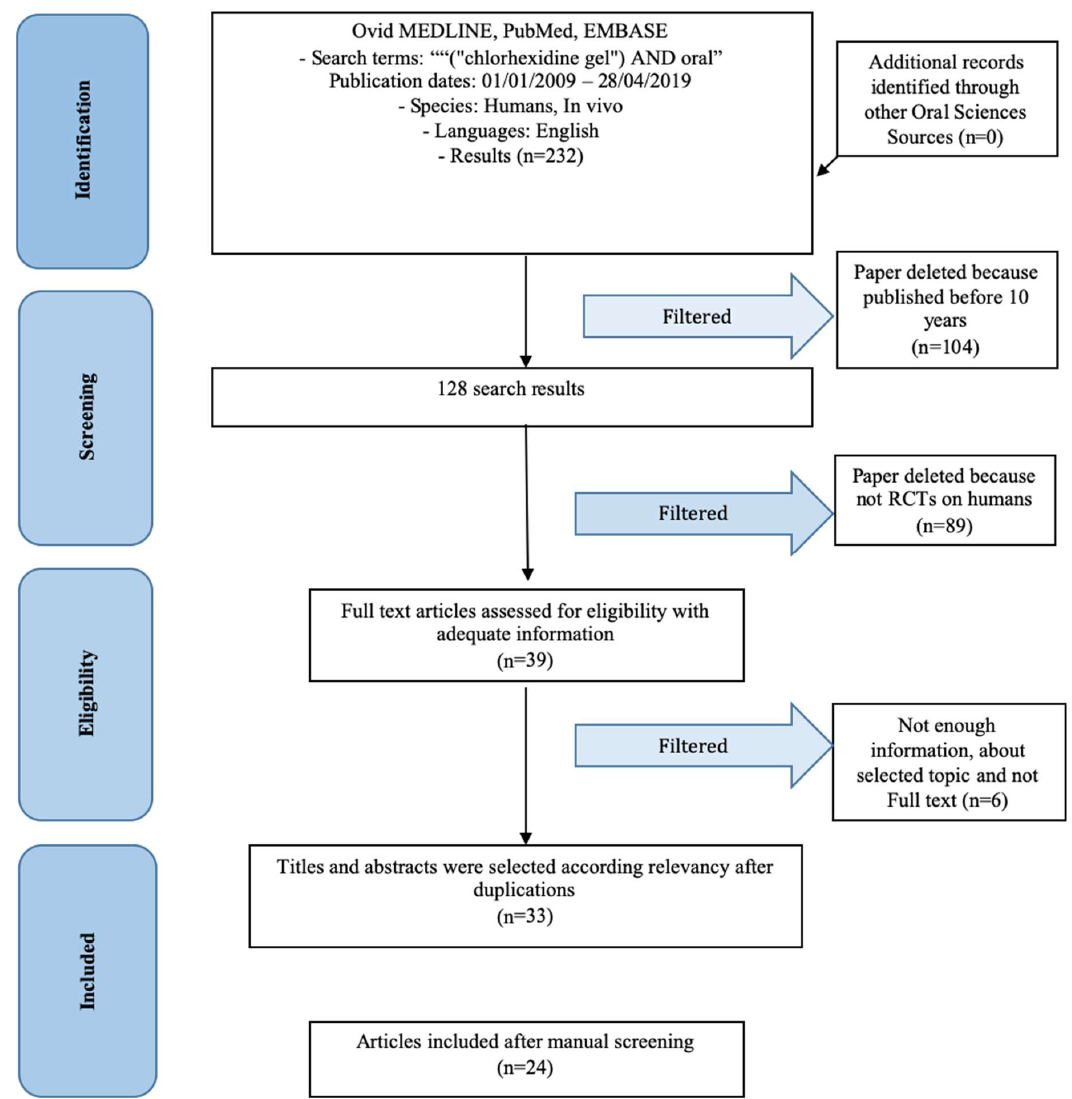
Figure 1. PRISMA Flow chart.